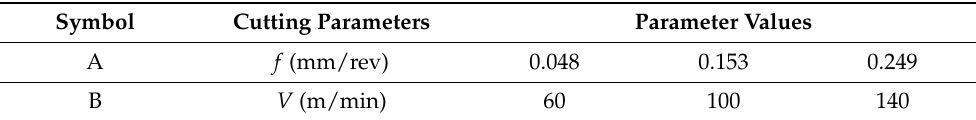
Table 3. Values of cutting parameters [36].